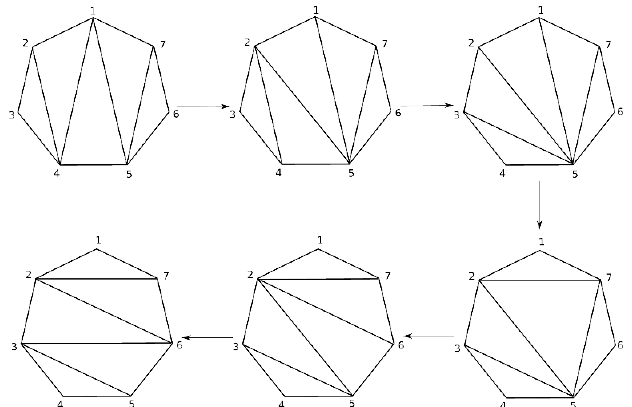
Figure 10. The classical monodromy action in the ( A 1 ; A 4 ) theory is realized by a sequence of (cid:13)ips of triangulations of the 7-gon. The initial triangulation di(cid:11)ers from the (cid:12)nal one by a clockwise rotation by 2